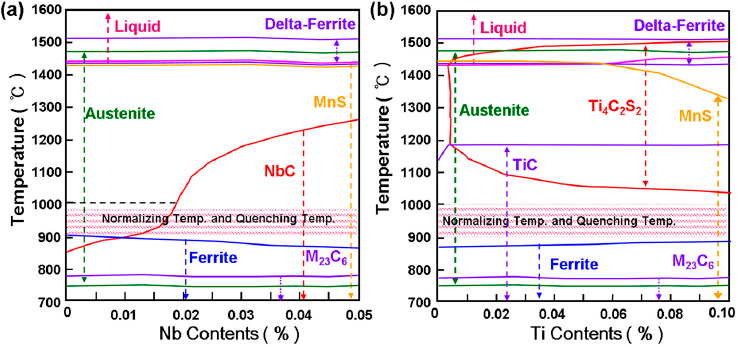
Figure 7. ( a ) Effect of Nb addition between 0% and 0.05%; ( b ) effect of Ti addition between 0% and 0.1% on the transformation lines of model A + (element) phase diagrams.